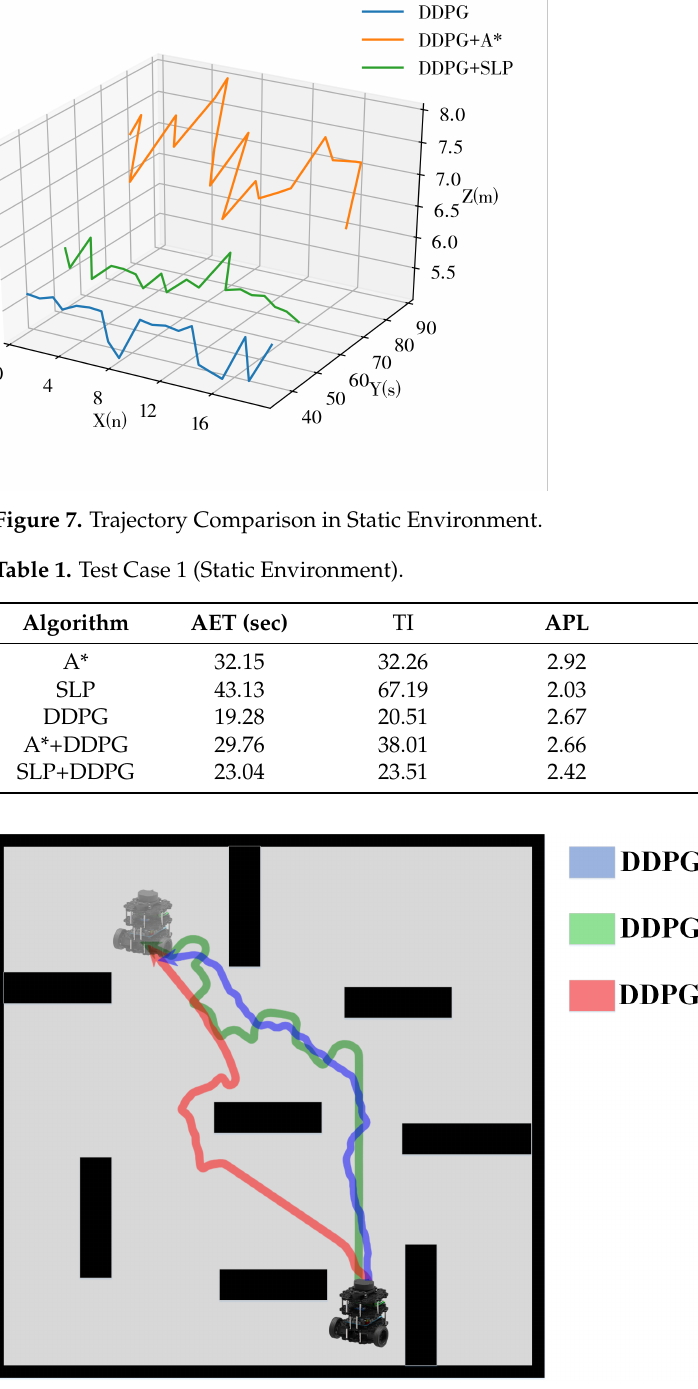
Figure 8. Robot Trajectory of Different Method in Static